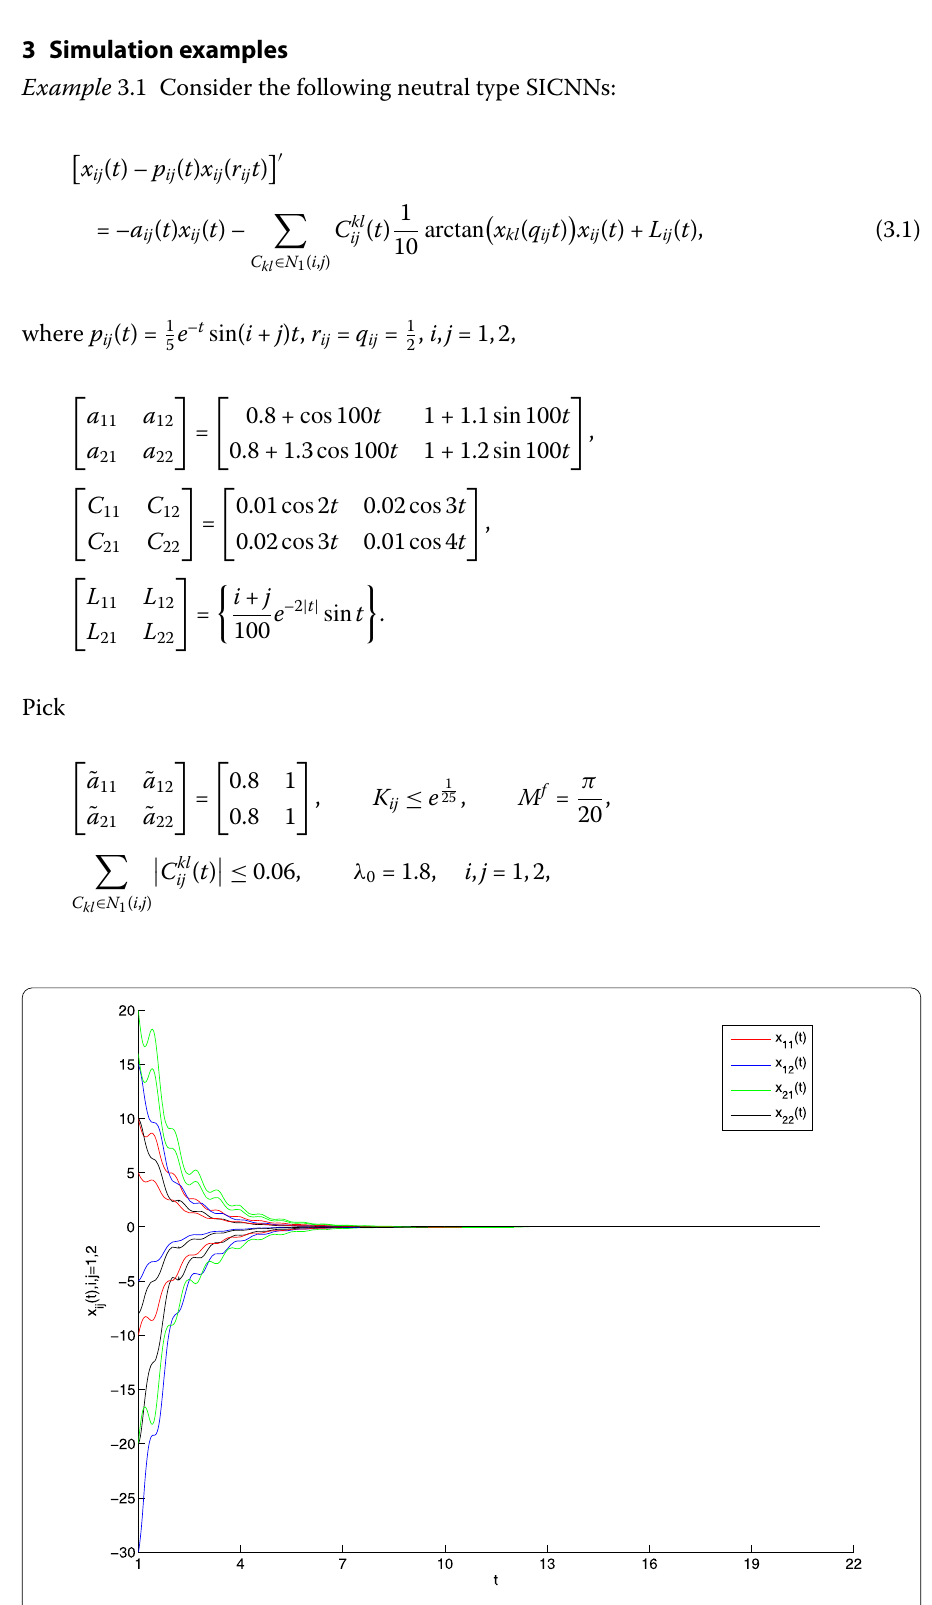
Figure 1 Numerical solutions of system (3.1) with different initial